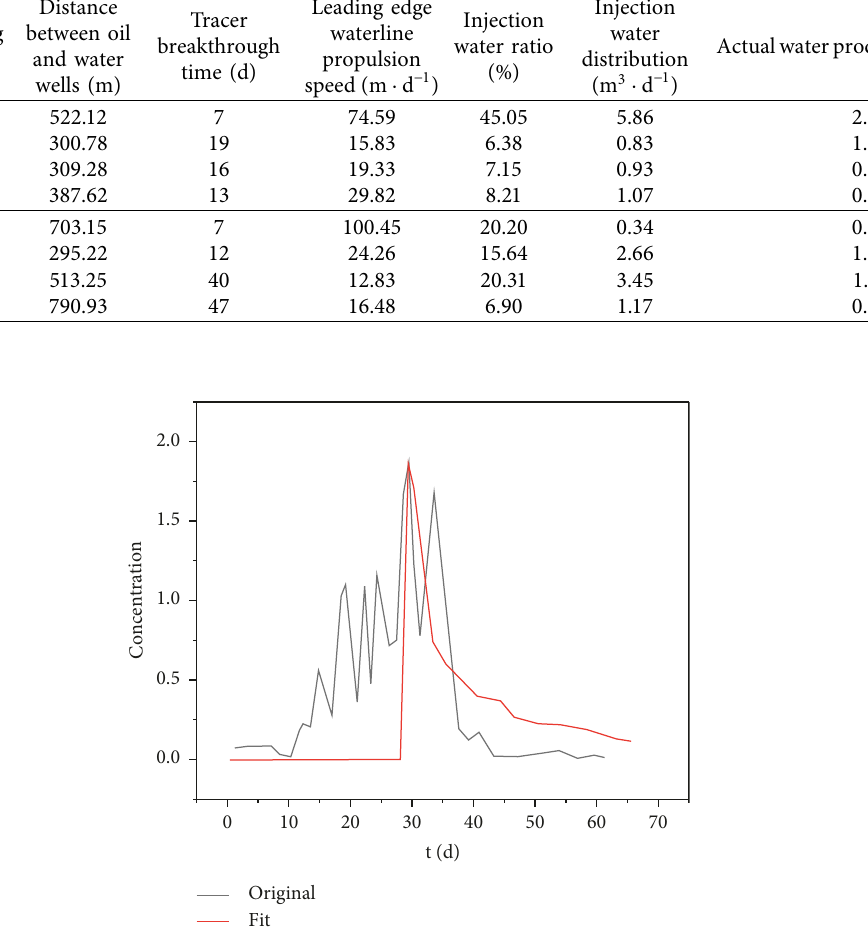
Figure 2: Tracer Yb production concentration curve of well